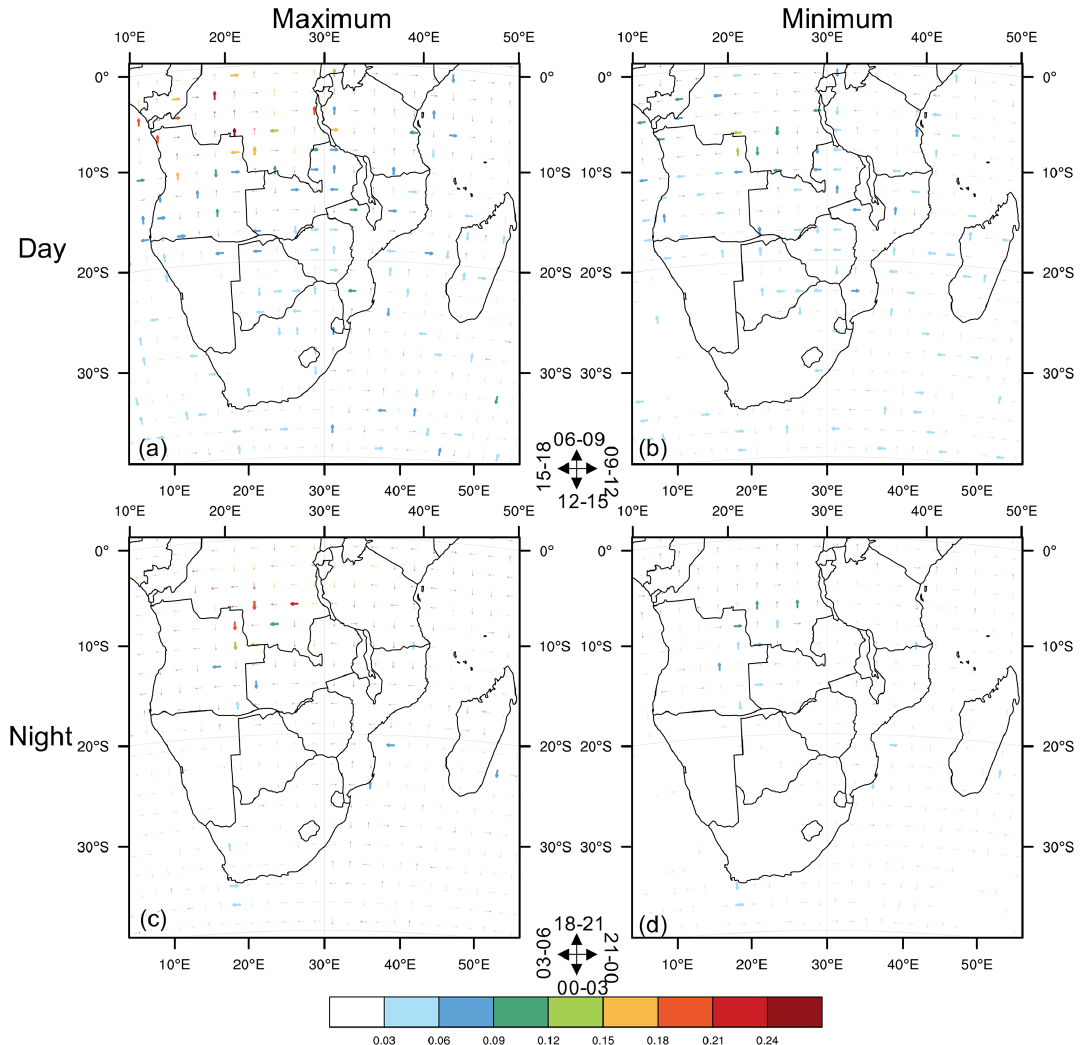
Figure 8. Diurnal (a, c) maximum and (b, d) minimum DAOD across southern Africa during the (a, b) daytime and (c, d) nighttime periods. Figure elements are the same as in Fig.